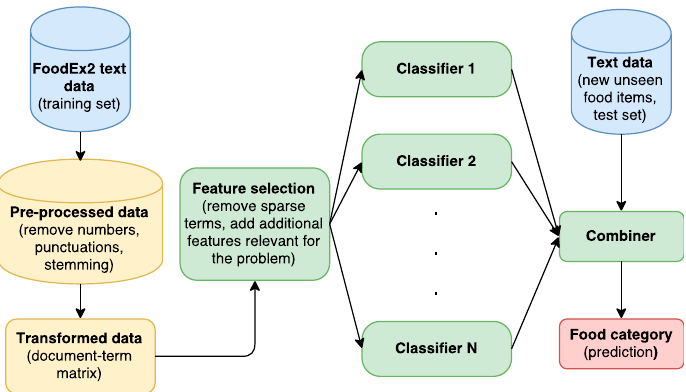
Figure 1. The StandFood classification part flowchart. FoodEx2 names are used as training instances. They are pre-processed by removing numbers and punctuations and stemming. Then,